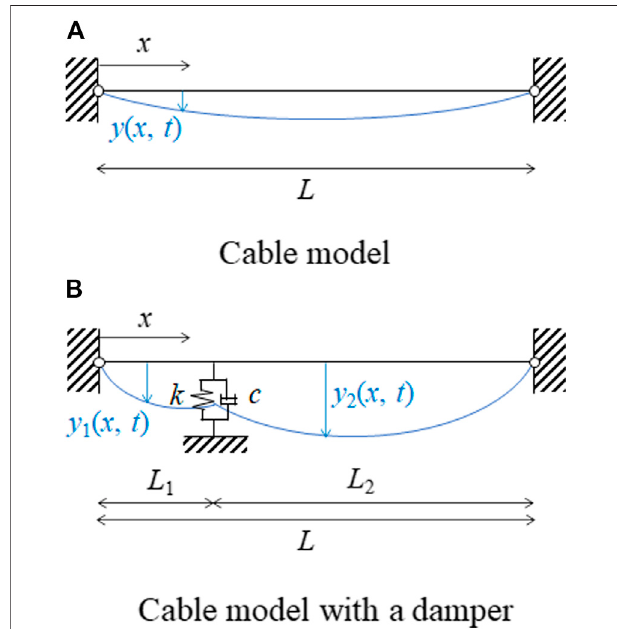
FIGURE 1 | Analytical model: (A) cable model; (B) cable model with